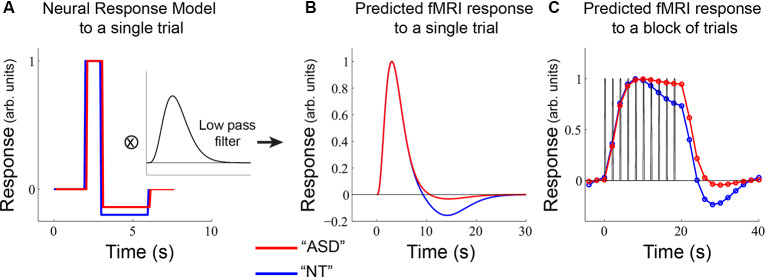
A model of potential underlying differences in neural response in sensory-motor regions. (A) ASD and NT participants were modeled as having the same increase in neural response but differences in neural offset responses. This neural response was passed through a low-pass filter to obtain the predicted fMRI response to a single stimulus event (B). (C) A predicted fMRI response was obtained by convolving the function in (B) with a block of 10 trials (as used in the main experiment).